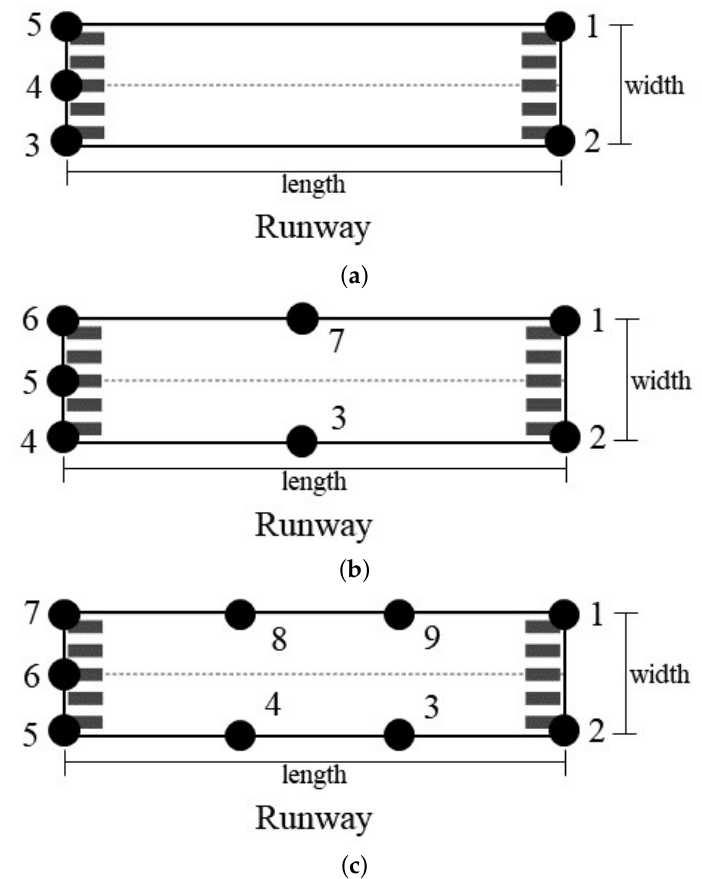
Figure 8. Schematic of runway feature point layout. ( a ) Five feature points. ( b ) Seven feature points. ( c ) Nine feature